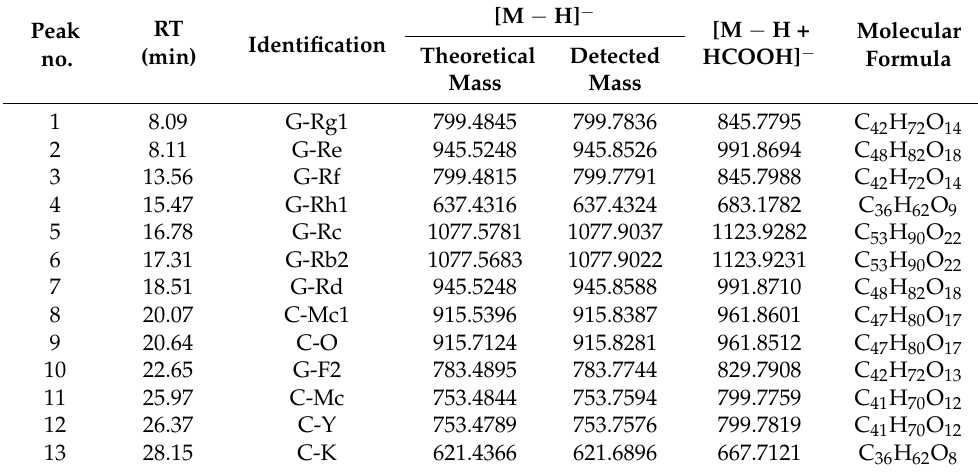
Table 1. UPLC/Q-TOF-MS analysis of biotransformation products from PPDG-F by